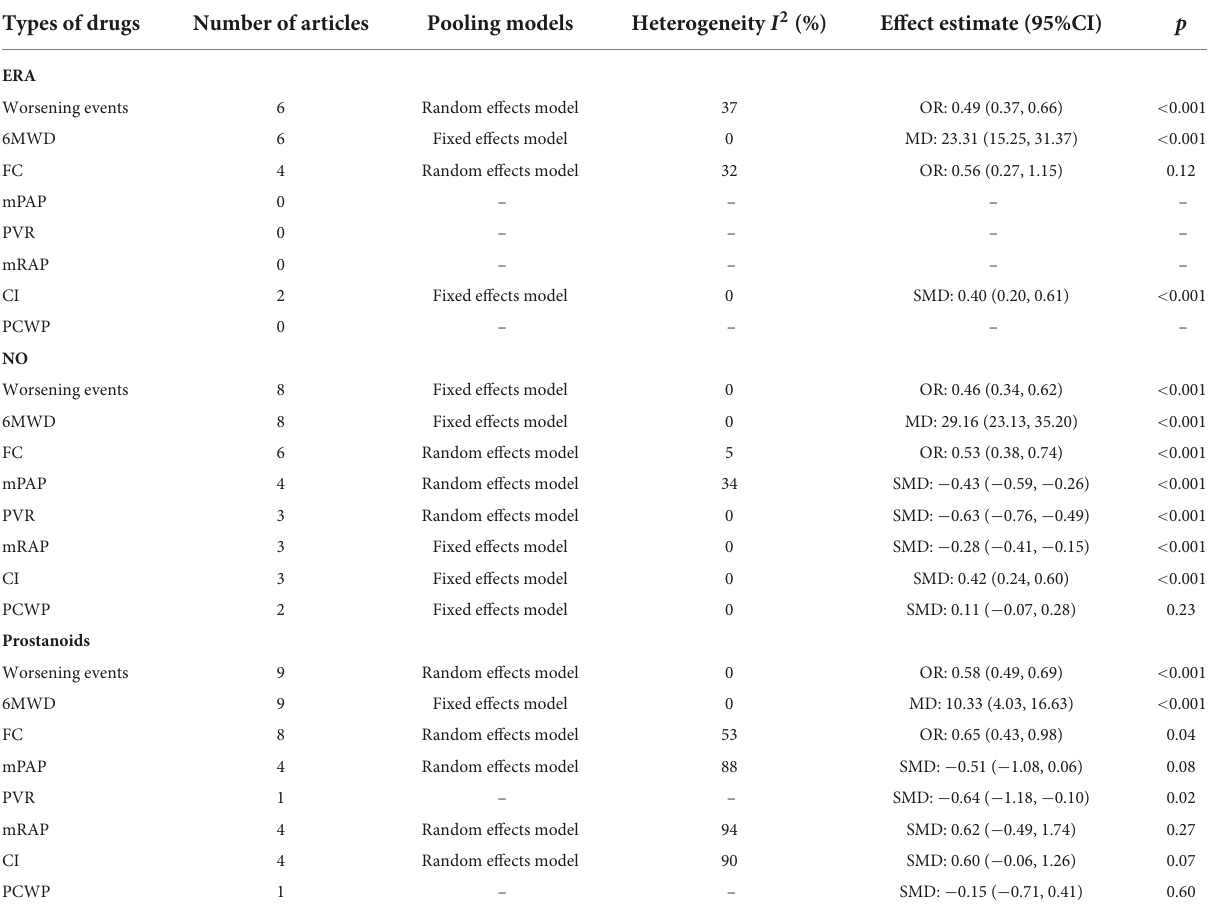
TABLE 3 Data on safety, exercise capacity, and hemodynamics for different drugs. Types of